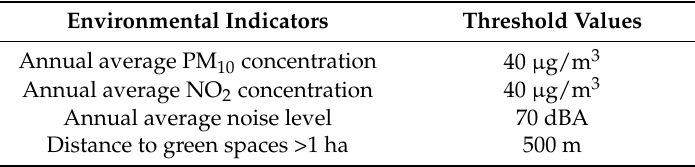
Table A2. Environmental standards used during the